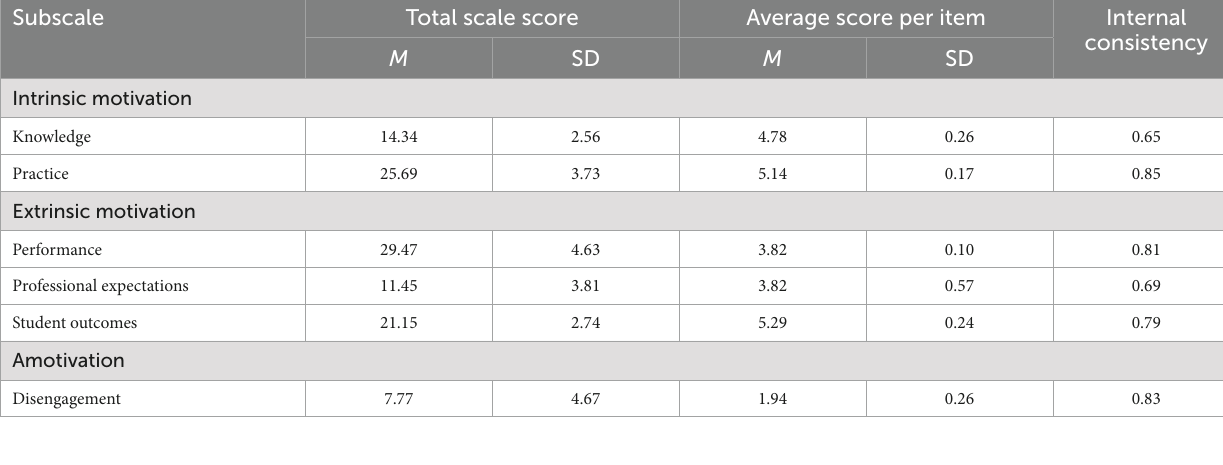
TABLE 3 Descriptive statistics and internal consistency for the physical education teaching efficacy